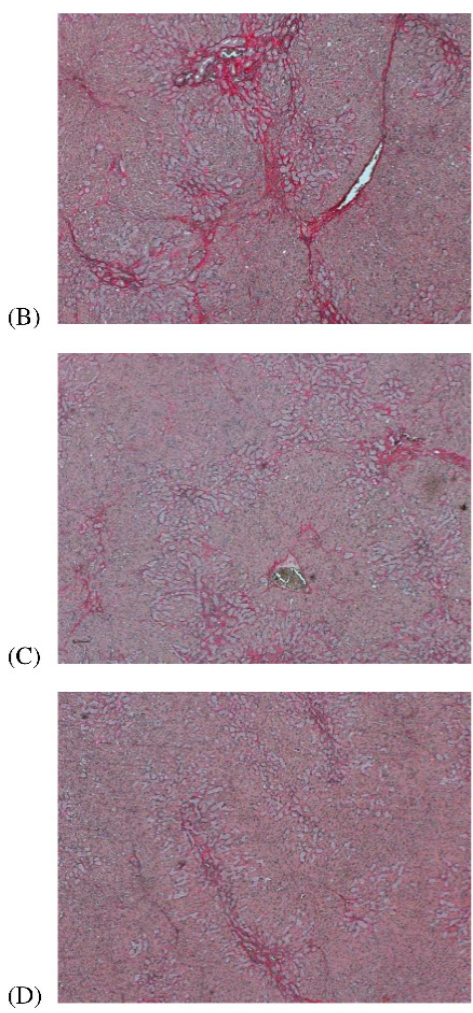
Figure 5. ( A ) The Sirius red-stained area of liver in CBDL rats treated with vehicle, I3C, or DIM analyzed with ANOVA. I3C and DIM significantly decreased the Sirius red-stained area (* p < 0.05, DIM or I3C vs. vehicle). The representative images of ( B ) CBDL-vehicle, ( C ) CBDL-DIM, and ( D ) CBDL-I3C groups are shown (in magnification